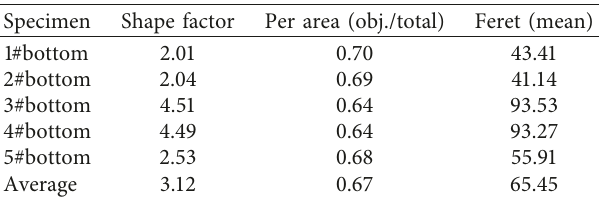
Table 6: Pore structure parameters of the aerated concrete block